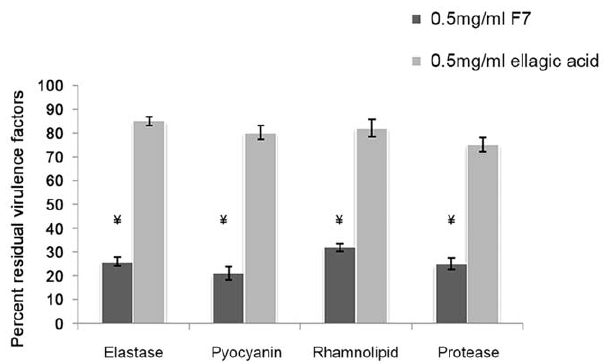
Figure 9. Comparative effect of F7 and ellagic acid on the production of virulence factors at 0.5 mg/ml. Elastase OD 490 nm/ 600 nm 0.654,Pyocyanin OD 540 nm/600 nm 1.08, Rhamnolipids OD 570 nm/ 600 nm 0.456 and Protease OD 400 nm/600 nm 0.876 were taken as 100% in untreated P. aeruginosa PAO1.